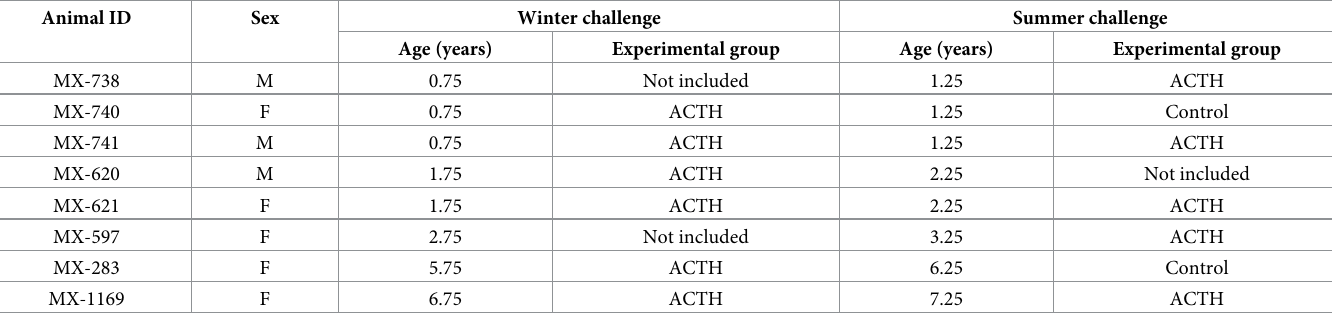
Table 1. Identification (ID), sex, age, and experimental group of the animals included in the winter and summer ACTH challenges and sampled for feces. Animal ID